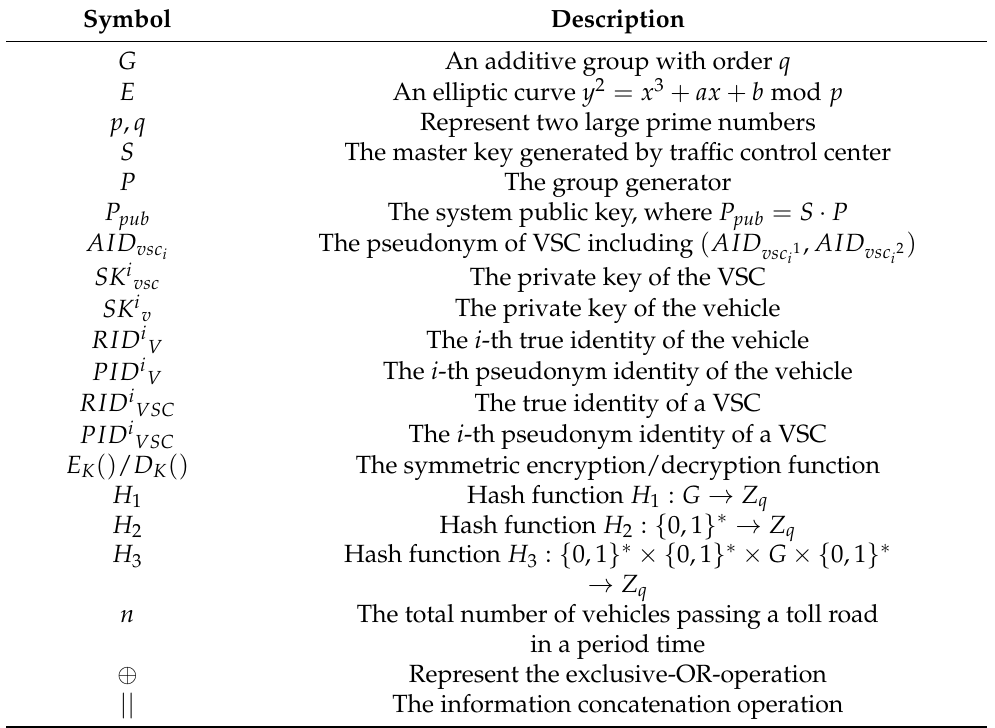
Table 1. Notations in our